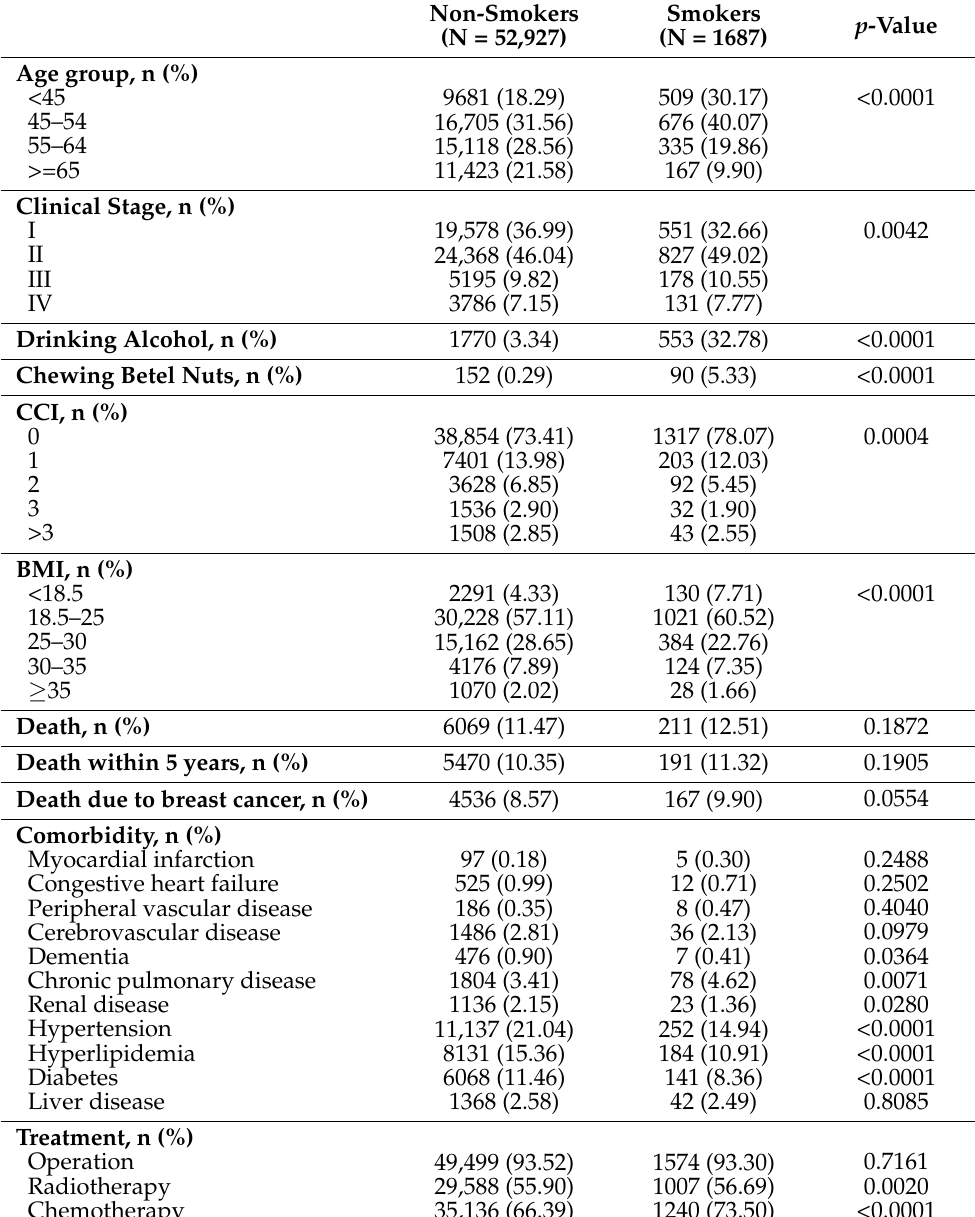
Table 1. Baseline characteristics between smokers and non-smokers among women with breast